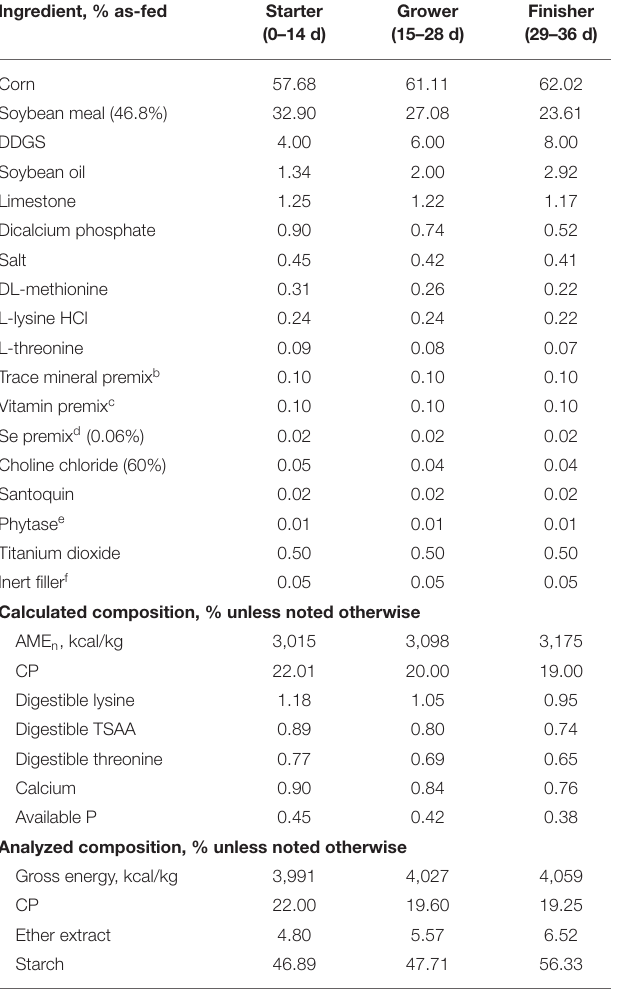
TABLE 1 | Composition of experimental diets fed to broilers from 0 to 36 d post-hatch a . Ingredient, % as-fed